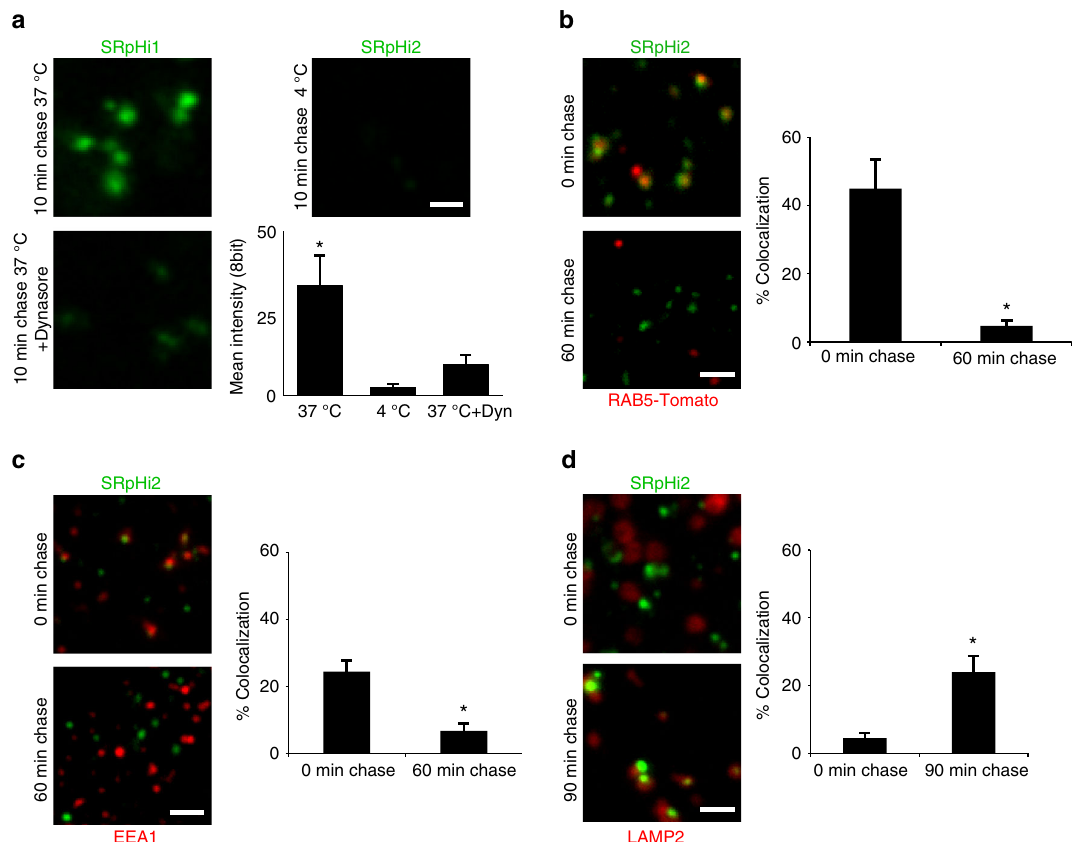
Fig. 2 SRpHi is targeted to the endocytic pathway. a HeLa cells were untreated ( top images ) or incubated with 80 μ M Dynasore ( bottom image ) for 45 min. Cells were then pulsed with SRpHi1 for 10 min at 37 °C ( left images ) or 4 °C ( right image ) followed by fi xation. The mean 8-bit intensity of all detectable endosomes was calculated and displayed. b – d CV-1 cells transfected with tdTomato-RAB5a b or untransfected c , d were pulsed with SRpHi2 for 10 min followed by fi xation or a 60 – 90 min chase in normal growth medium. Cells were immunostained for EEA1 c or LAMP2 d , and colocalization between SRpHi and RAB5a b , EEA1 c , or LAMP2 d was determined using a custom-written Matlab script. Mean percent colocalization from 5 to 10 cells was calculated and plotted for the pulse and pulse/chase conditions. Error bars represent standard deviation from the mean; * represents a p -value of < 0.05 as calculated by a 2-tailed Student ’ s t -test. Data are representative of three independent experiments. Scale bars = 1 µ